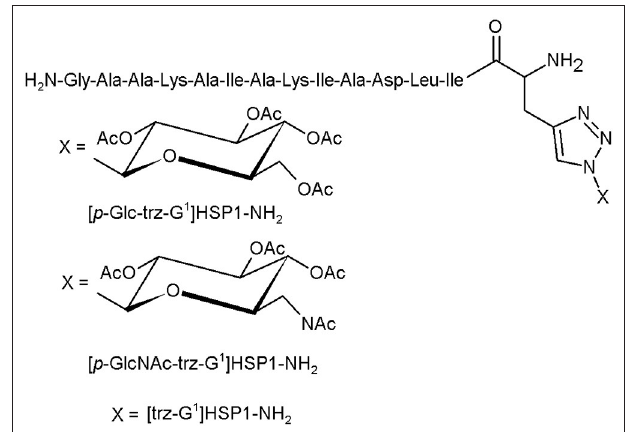
FIGURE 5 | The glycotriazole-peptide derivatives (Junior et al., 2017).